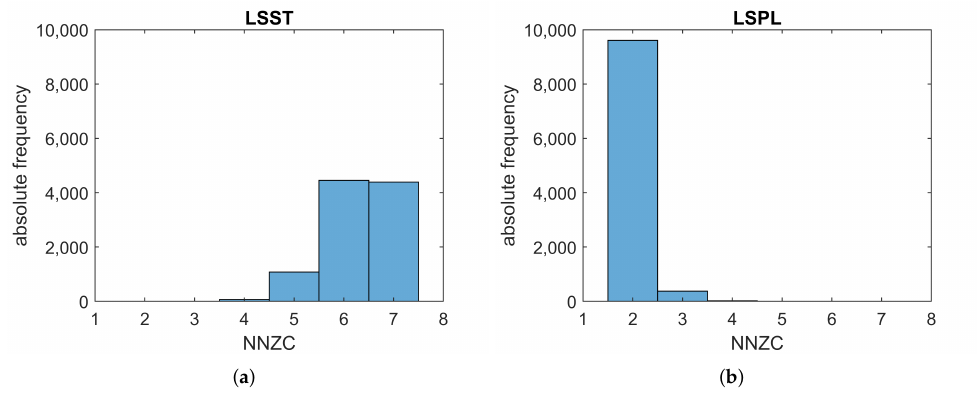
Figure 3. Distribution of NNZC of the methods ( a ) LSST and ( b ) LSPL, Ord = 3, (cid:101) N = 0.005. The median, 0.25 quantile, and 0.75 quantile were chosen to represent the NNZCs of all 25 MCSs with five different noise factors and five polynomial orders in Figure 4. The total numbers of candidate functions for each polynomial order are marked by horizontal lines with corresponding colors, which are also the maximum possible values of NNZC.